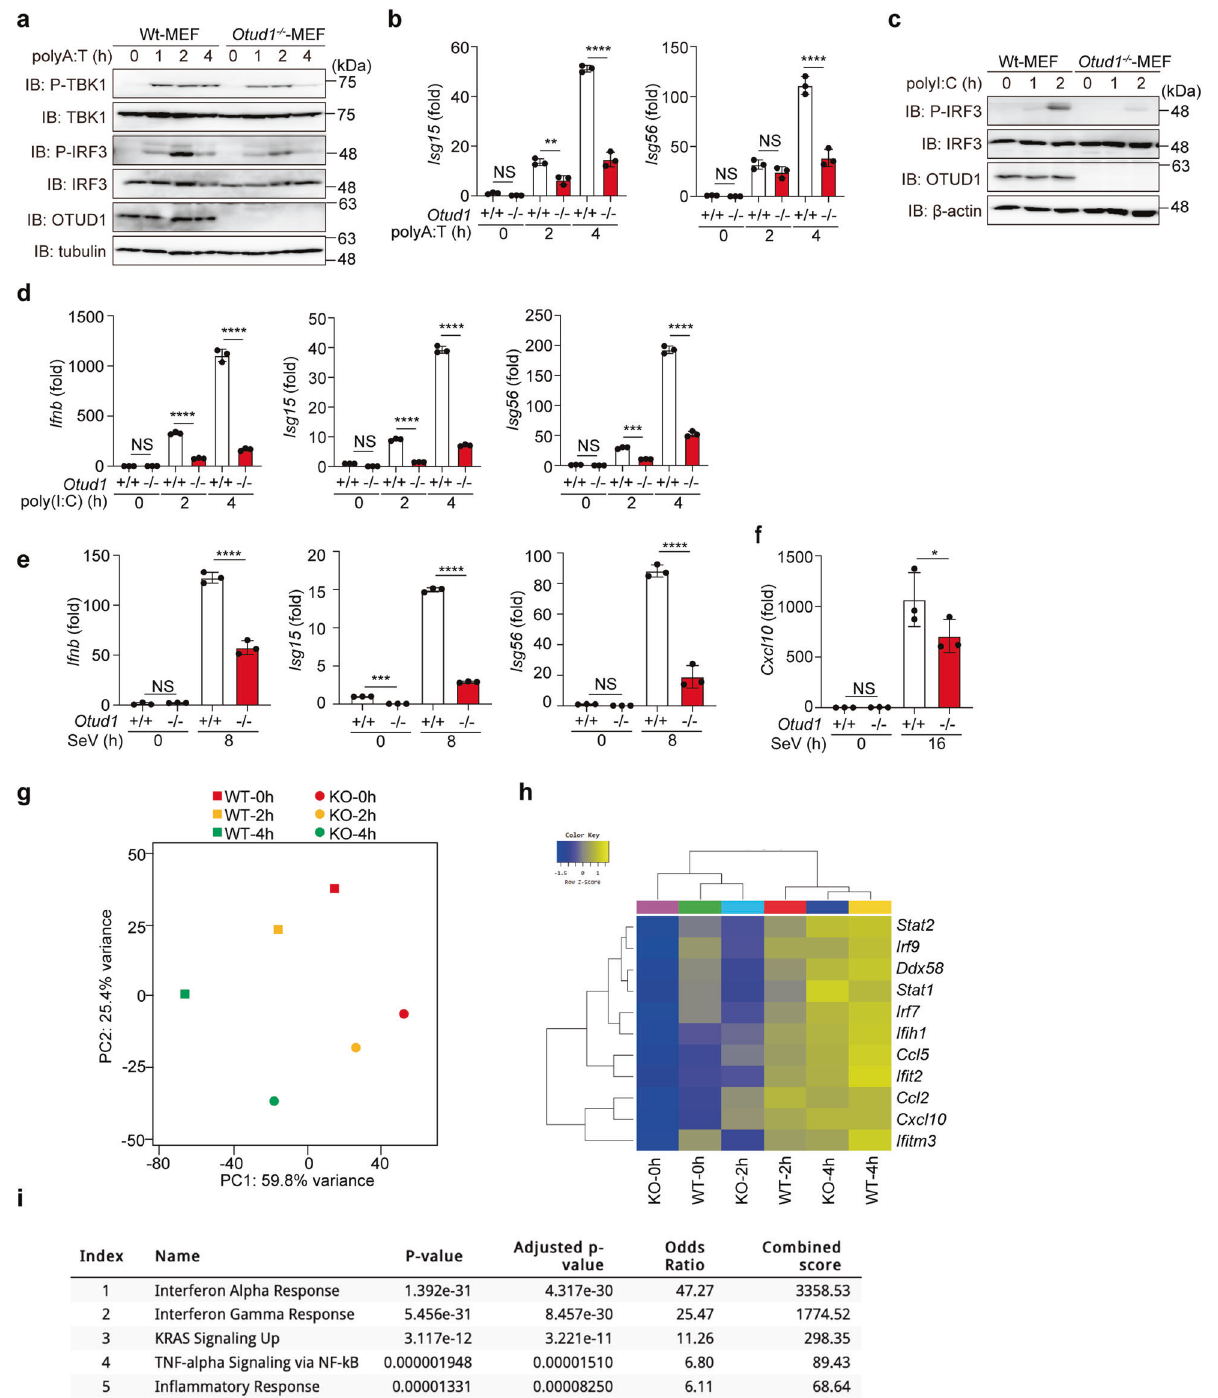
Fig. 3 OTUD1 upregulates type I IFN antiviral pathway. a The poly(A:T)-mediated IFN antiviral pathway is suppressed in Otud1 − / − -MEFs. Otud1 + / + - and Otud1 − / − -MEF cells were stimulated with 1 μ g/ml poly(A:T) for the indicated periods, and the cell lysates were immunoblotted with the indicated antibodies. b The expression of IRF3-target genes is suppressed in poly(A:T)-treated Otud1 − / − -MEF cells. MEFs were stimulated with 1 μ g/ml poly(A:T) for the indicated periods, and the mRNA levels were assessed by qPCR. c The suppressed poly(I:C)-mediated antiviral response in Otud1 − / − -MEFs. Otud1 + / + - - and Otud1 − / − -MEFs were stimulated with 10 μ g/ml poly(I:C) for the indicated periods, and cell lysates were immunoblotted with the indicated antibodies. d Reduced poly(I:C)-mediated antiviral response in Otud1 − / − -BMDMs. BMDMs from Otud1 + / + - - and Otud1 − / − -mice were stimulated with 10 μ g/ml poly(I:C) for the indicated periods, and a qPCR analysis was performed. e , f Sendai virus (SeV)-induced antiviral response is suppressed in Otud1 − / − -cells. Otud1 + / + - - and Otud1 − / − -MEFs ( e ) or BMDMs ( f ) were infected with SeV at a CIU of 10 for 1h, incubated for the indicated periods, and then subjected to qPCR analyses. b , d – f Data are shown as mean±SD by ANOVA post-hoc Tukey test ( n = 3). * P <0.05, ** P <0.01, *** P <0.001, **** P <0.0001, NS: not signi fi cant. g – i Suppressed transcription of IRF3-target genes in Otud1 − / − -MEFs. Otud1 + / + - and Otud1 − / − -MEFs were stimulated with 10 μ g/ml poly(I:C) for 2 and 4h, and RNA-seq analyses were performed. g A principal component analysis of the RNA-seq analysis. h Taking the cutoff value of 10, signi fi cantly varied mRNAs are shown by the heatmaps. i Taking the cutoff value of 3.0, pathway analyses of 179 down-regulated genes were performed by MSigDB Hallmark 2020 and listed in ascending order of P -value. Cell Death and Disease (2022)